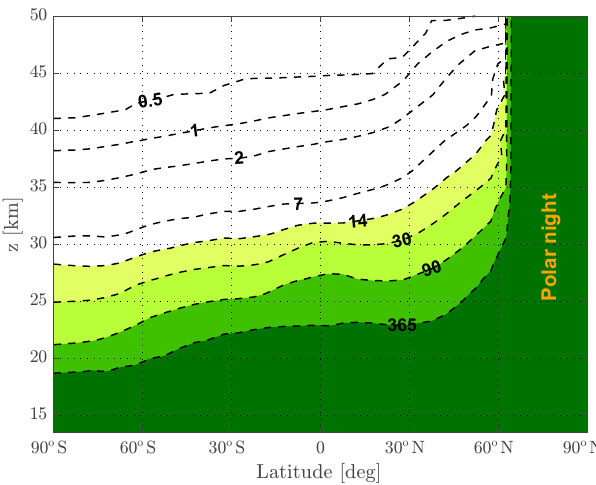
Figure 1. Zonal mean of O x lifetime in January derived from AT- LAS CTM data. Contour numbering shows the lifetime in